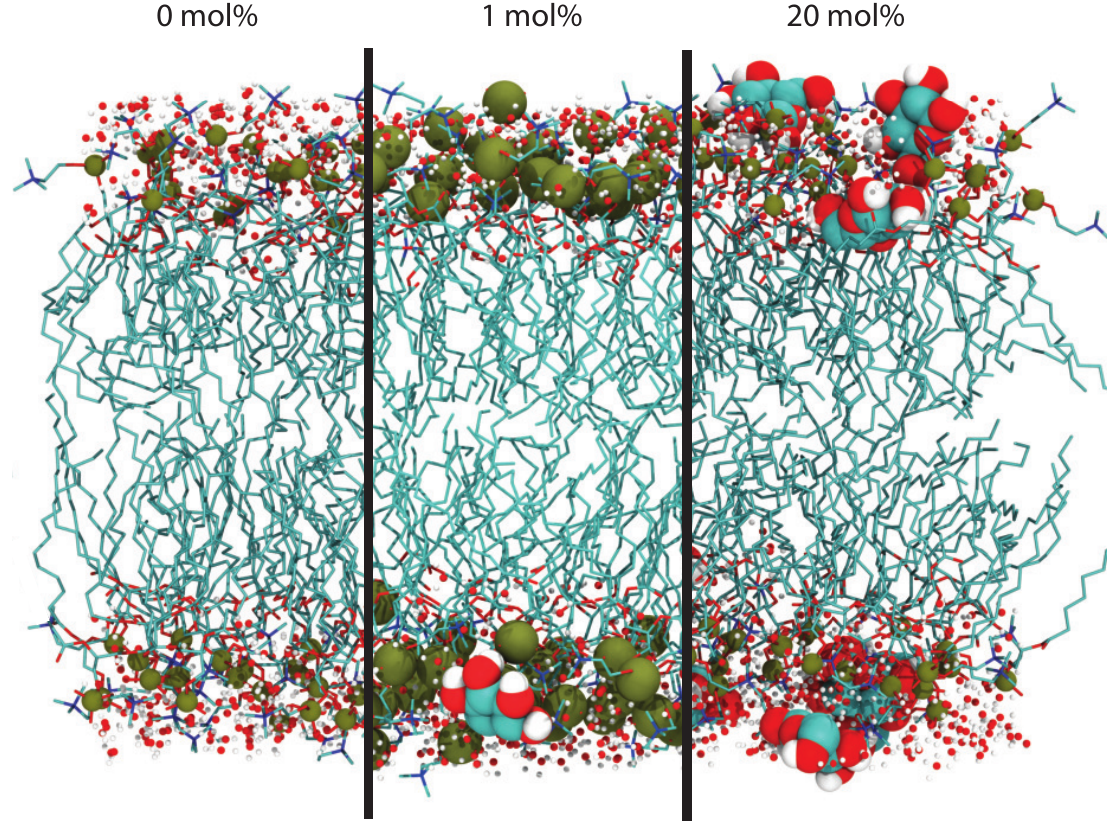
Figure 3. Comparison between dehydrated DMPC bilayers at 300 K for pure DMPC, 1 mol% glucose (enlarged phosphates), and 20 mol% glucose. Oxygen is displayed in red, carbon in teal, hydrogen in white, nitrogen in blue, and phosphorous in tan. Glucose spontaneously partitioned in the head group region of the